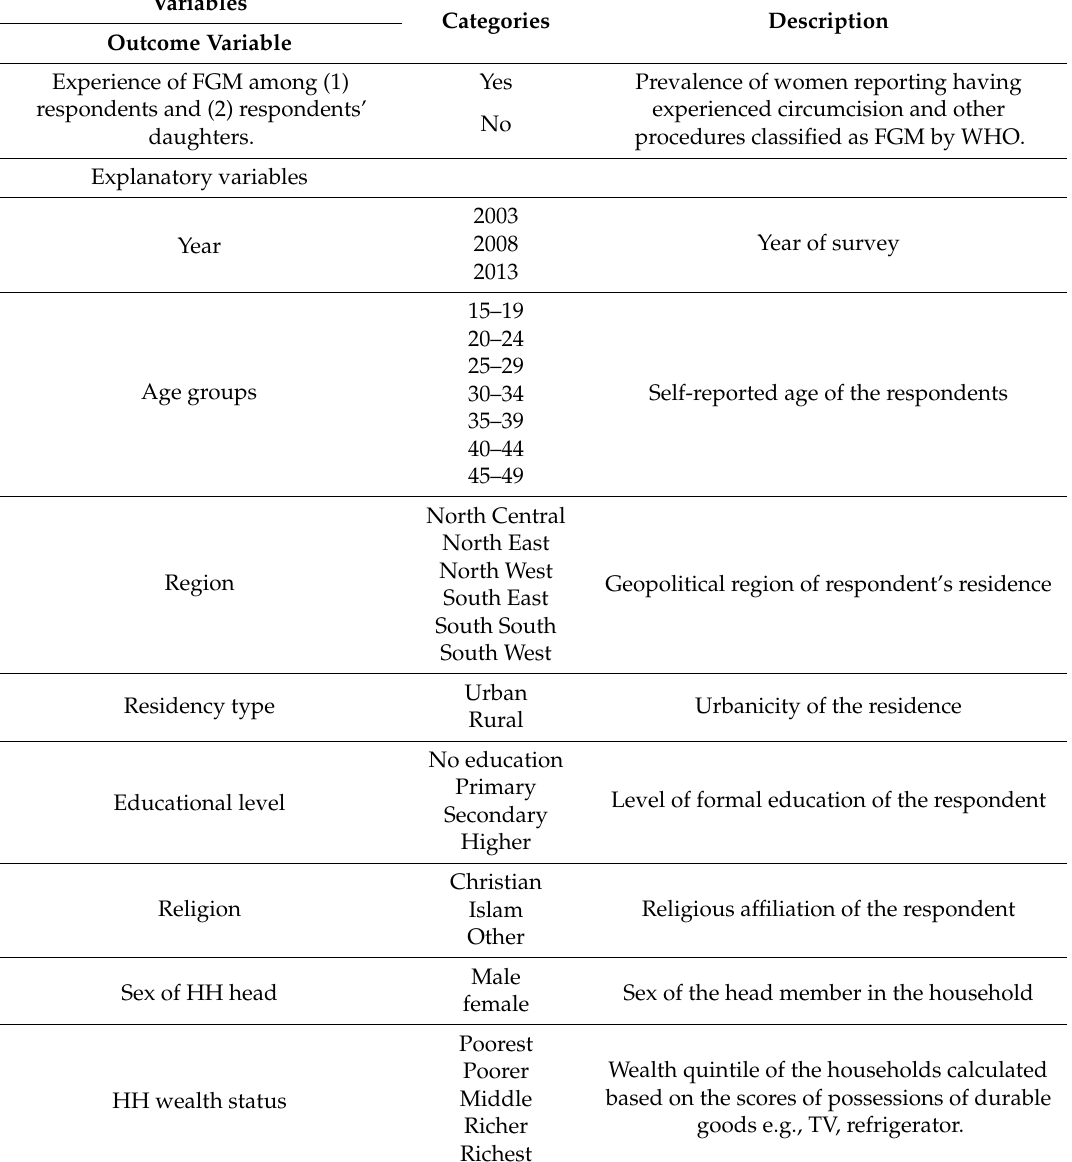
Table 1. Variables used in the